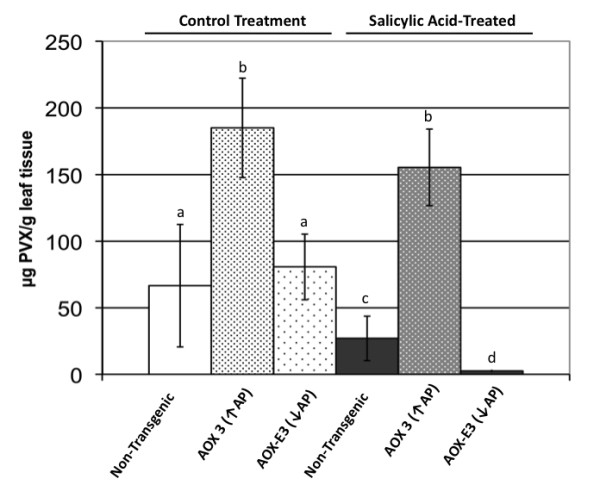
The effects of altering alternative respiratory pathway capacity on salicylic acid (SA)-induced resistance to potato virus X (PVX). Plants were pre-treated by spraying with a solution of SA or a control solution for four days prior to inoculation with PVX. Samples from the fourth leaf above the directly PVX-inoculated leaves of plants were harvested at 28 days post-inoculation and processed for an enzyme-linked immunosorbent assay using anti-PVX coat protein serum. Mean accumulation (μg PVX per gram of leaf tissue) was determined using a standard curve and the data from one experiment, out of a total of three independent experiments, are plotted above. The number of samples was six for each plant line (one sample = one plant) in each treatment group. Error bars represent mean ± standard error of the mean. Accumulation of virus was significantly different between non-transgenic and AOX 3 Aox-transgenic plants (p = 0.044) and between SA-treated and SA-treated AOX3 Aox-transgenic plants (p = 0.020). Mean titer values labelled with the same lower case letter were not significantly different from each other (t-test, p > 0.05).